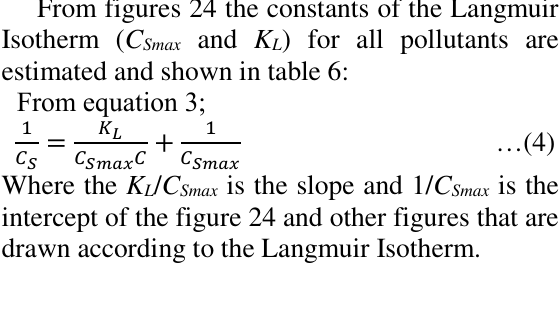
Table 6, Constants of Langmuir isotherm for all treated pollutants.